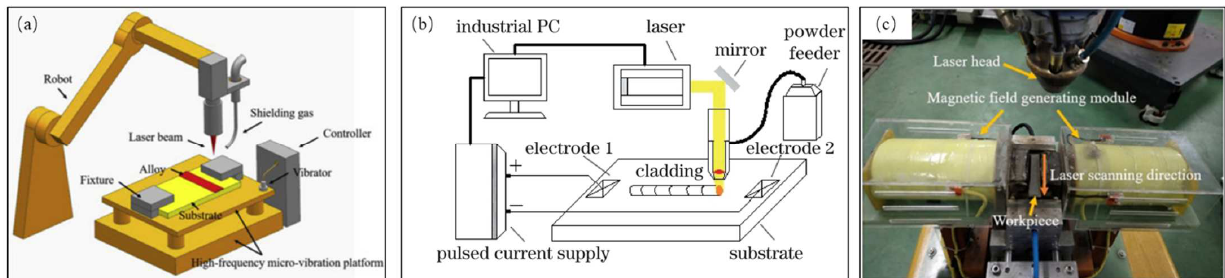
Figure 8. Schematics diagram and equipment diagram for coupling physical fields: ( a ) the schematic diagram of high-frequency micro-vibration coupling fields; ( b ) the schematic diagram of electric coupling fields; ( c ) the equipment diagram of magnetic coupling fields.